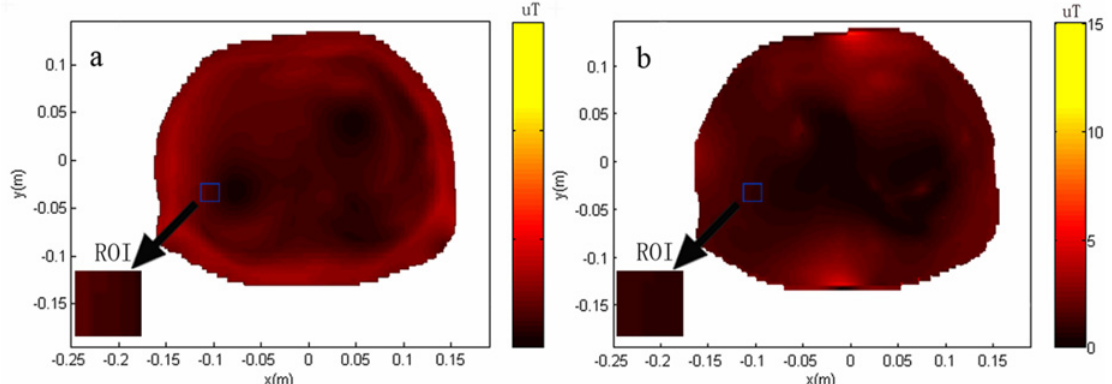
Fig 6. Theoretical B 1 field distribution through the transverse planes centered at the ROI used for the calculation of RSD of different coils. (a) transverse plane of body coil, the RSD was 6.14% within the ROI, indicating the homogeneity of 93.86%; (b) transverse plane of phased array coil, the RSD was 19.90% within the ROI, indicating the homogeneity of 80.10%. The less the RSD means the more homogeneous B 1 field. The results showed that the homogeneity of the body coil is better than that of phase array